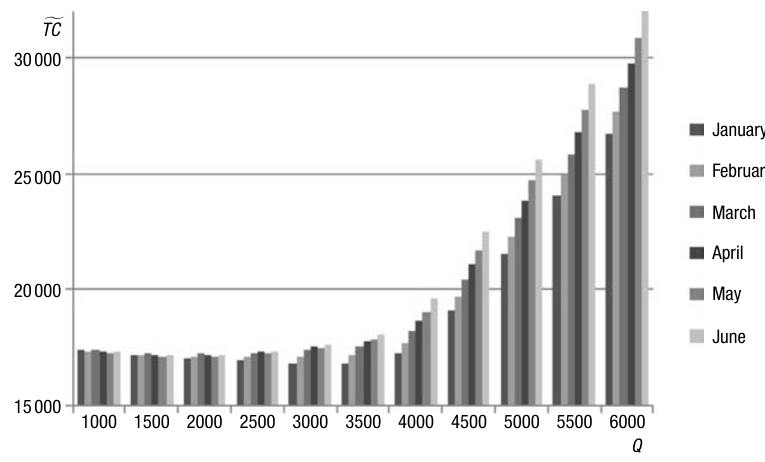
Fig. 6. Fuzzy total cost for pre-season ordering